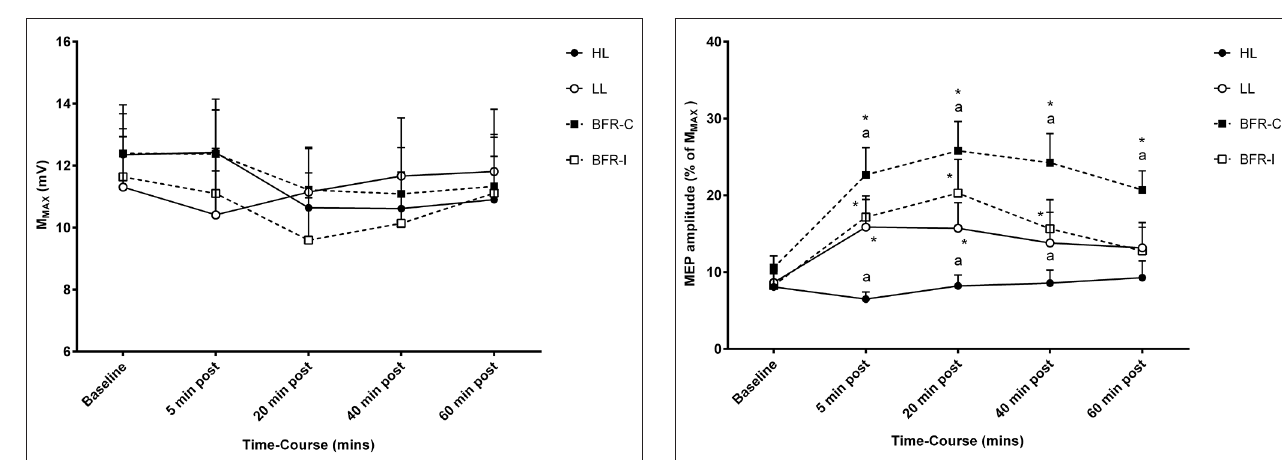
FIGURE 3 | MEP amplitude relative to M MAX following resistance exercise . HL, heavy-load resistance exercise; LL, light-load resistance exercise; BFR-C, blood flow restriction with continuous inflation of cuff pressure; BFR-I, blood flow restriction with intermittent inflation of cuff pressure. ∗ Indicates significantly different to Baseline ( p < 0.05); “a” indicates significantly different to all others trials ( p < 0.05).